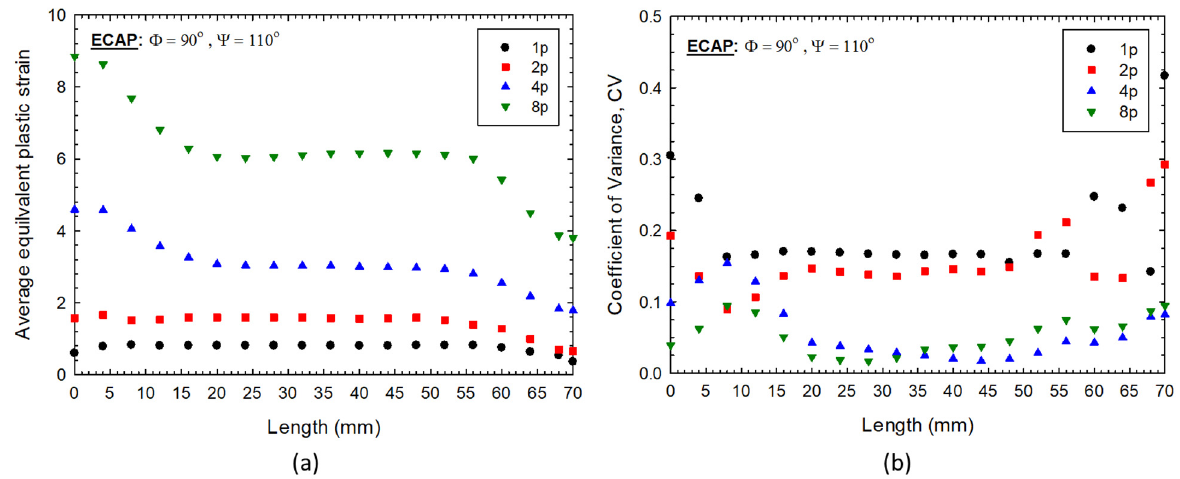
Figure 11. The plots of ( a ) average equivalent plastic strains and ( b ) coefficients of variance on different cross-sections over the length of the workpiece for various numbers of passes.